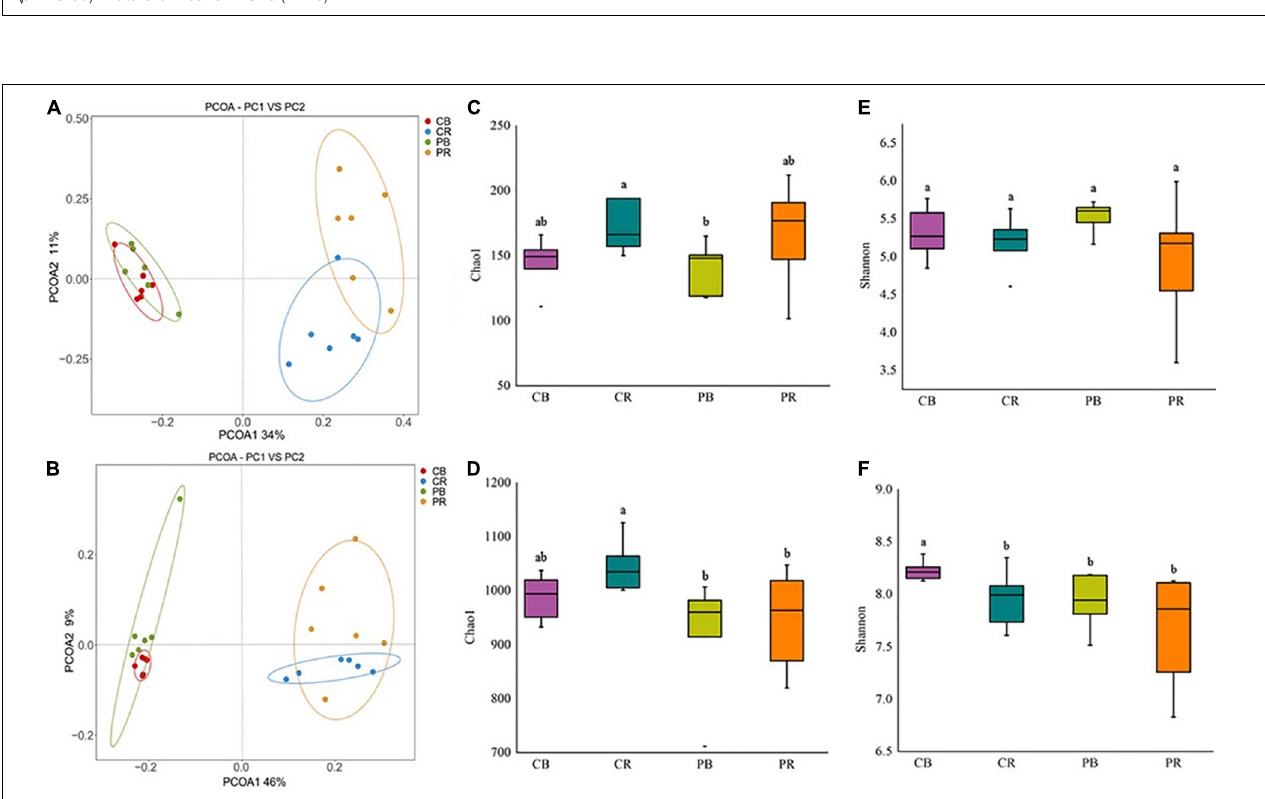
FIGURE 3 | Principal coordinate analysis (PCoA) of fungi (A) and bacteria (B) , community abundance and diversity indices of fungi (C,E) and bacteria (D,F) in conditioned and control soils. CB and CR represent control (C) bulk (B) and rhizosphere (R) soil, respectively. PB and PR represent conditioned (P) bulk (B) and rhizosphere (R) soil, respectively. Data are means ± SEs. a and b indicate significant differences among the soils ( p < 0.05).